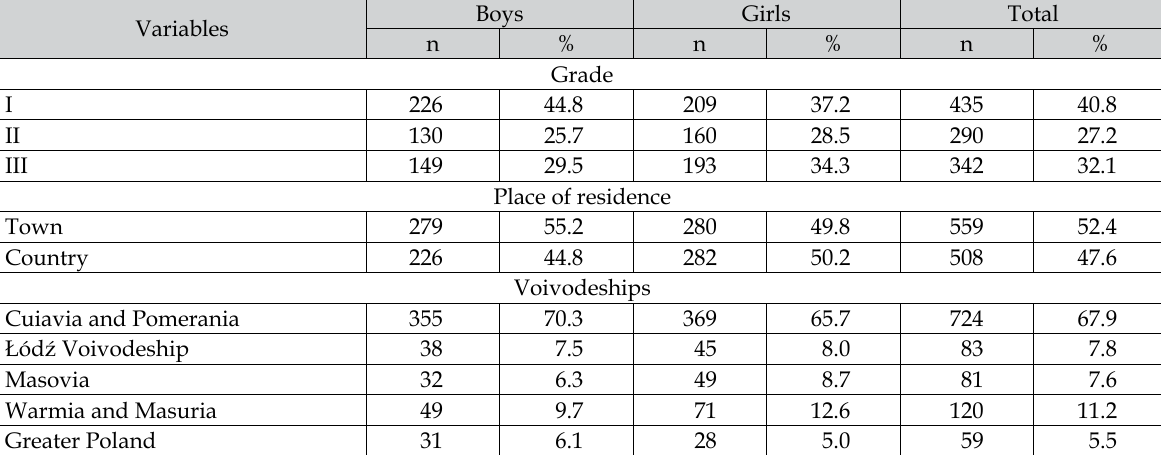
Table 1. characteristics of the researched group of young people from lower secondary schools of the selected voivodeships in Poland